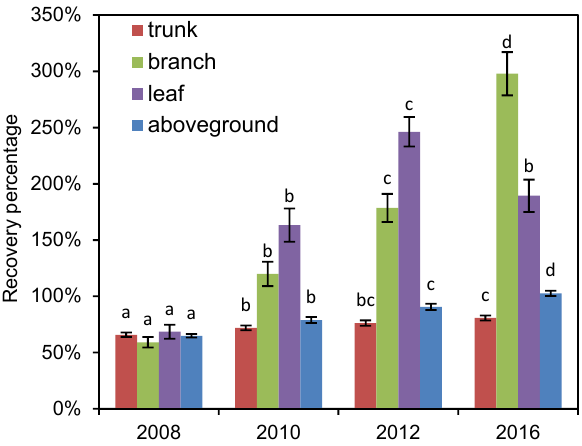
Figure 3. Proportion of average biomass of different tree compartments at different recovery stages after the ice storm compared to that of undamaged trees with the same diameter. The different lowercase letters on the columns indicate significant differences between the recovery stages tested by one-way ANOVA LSD.